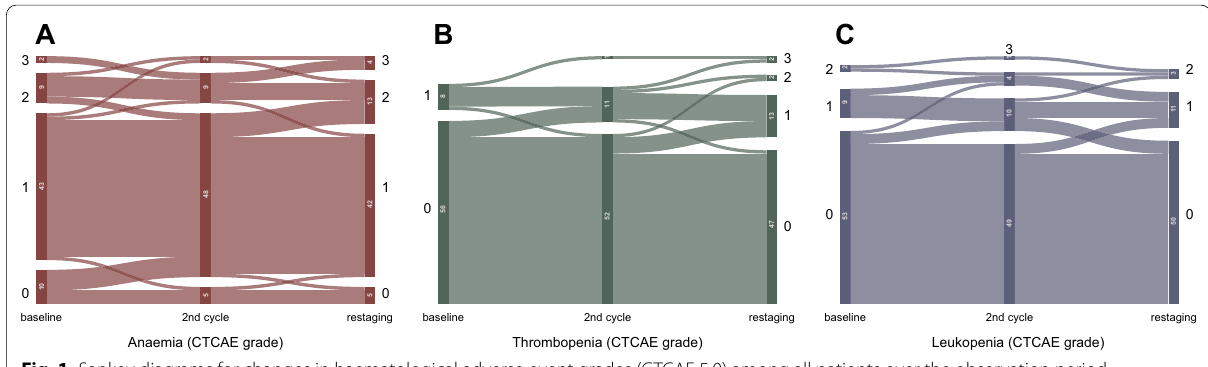
Fig. 1 Sankey diagrams for changes in haematological adverse event grades (CTCAE 5.0) among all patients over the observation period (summarised as three time points) for anaemia ( A ), thrombopenia ( B ) and leukopenia ( C )